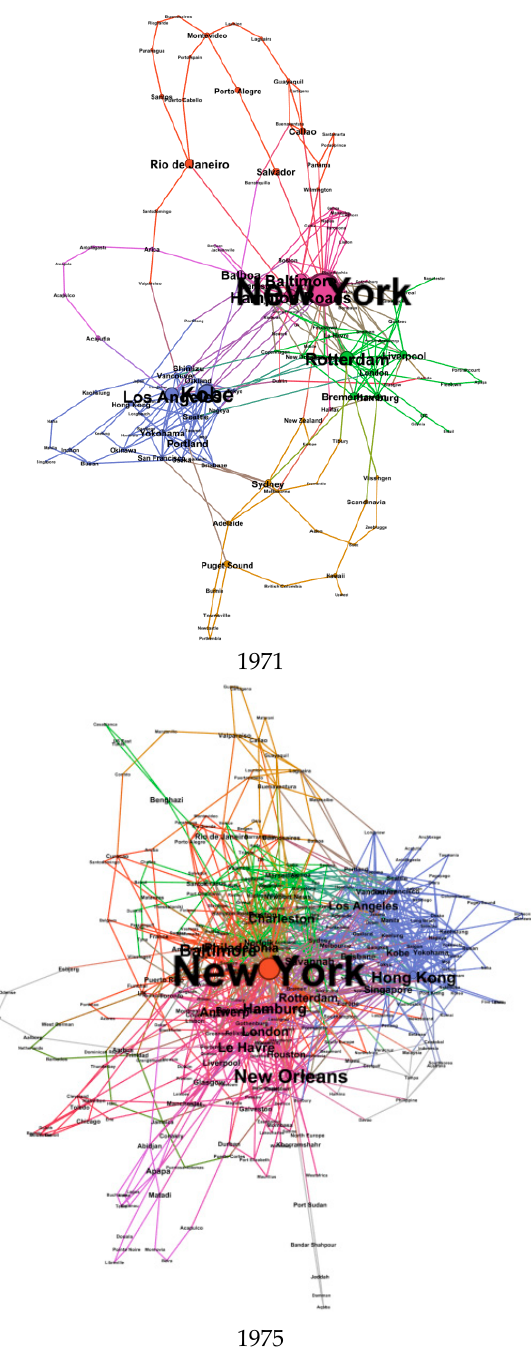
Figure 9. MCS network developed by the GDL-1 model in each year of the